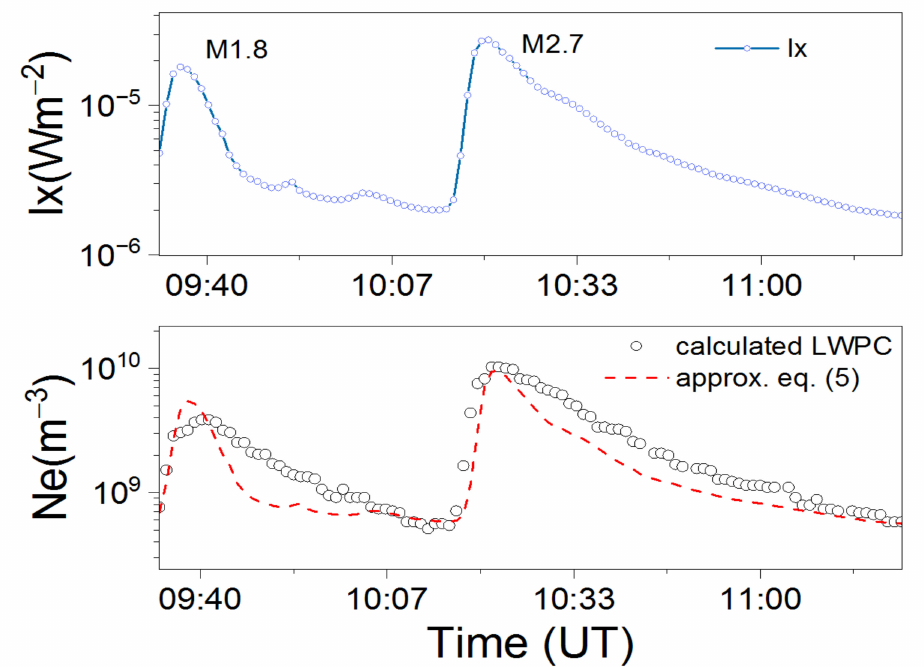
Figure 12. X-ray flux from GOES-15, and N e ( h = 74 km) as a function of UT during two M-class SFs on 12 June 2014. The dashed red line shows results acquired by approximative Equation (5). N e obtained by the above-mentioned method is presented by